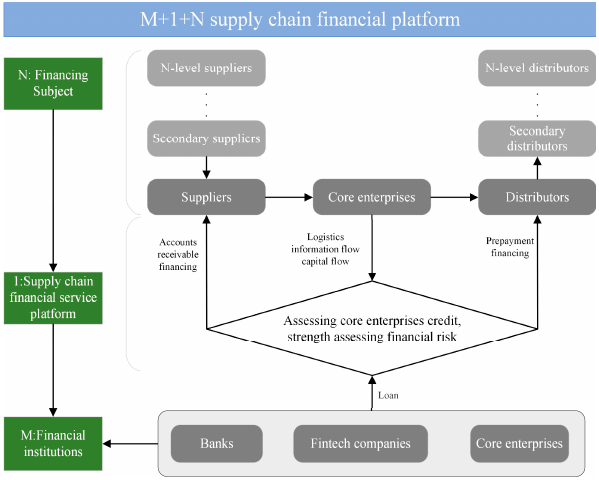
Figure 1. “M + 1 + N” supply chain financial platform.